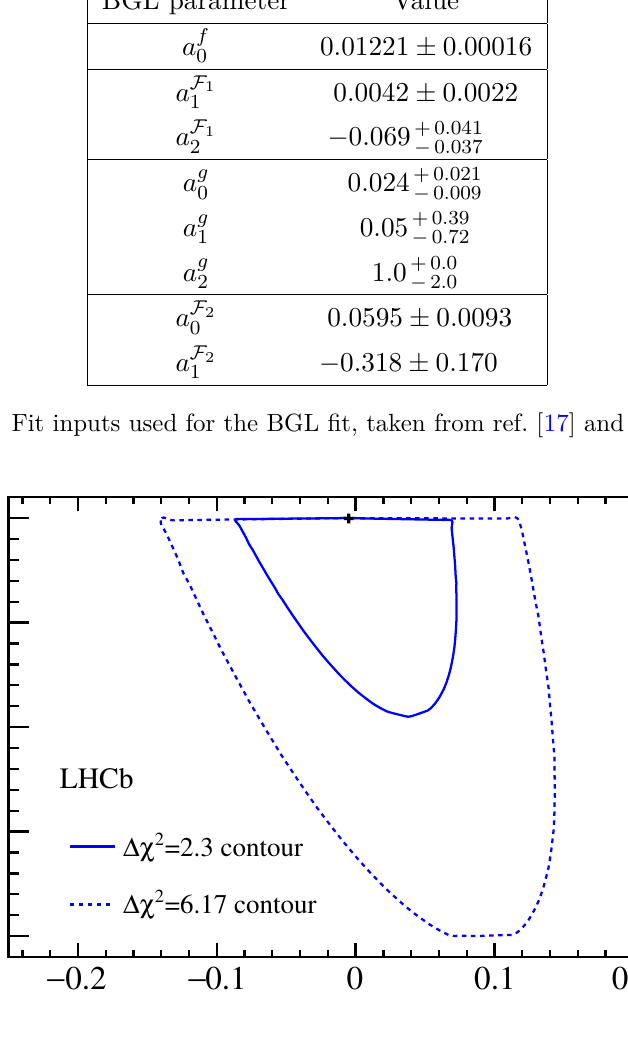
versus a f . The black cross marks the best-fit 1 2